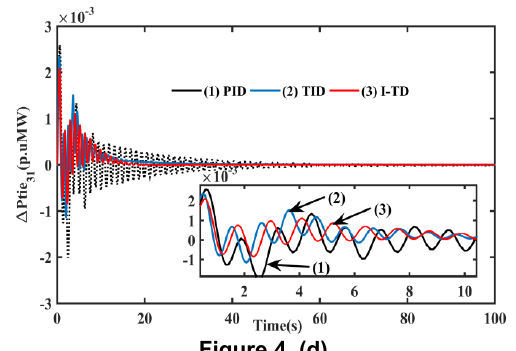
Figure 4. Dynamic response comparison of the system with PID, TID and I-TD controllers vs. time. (a) Frequency deviation in area-1, (b) Frequency deviation in area-2 (c) Tie-power deviation among area-1 and area-2 and, (d) Tie- power deviation among area-3 and area-1